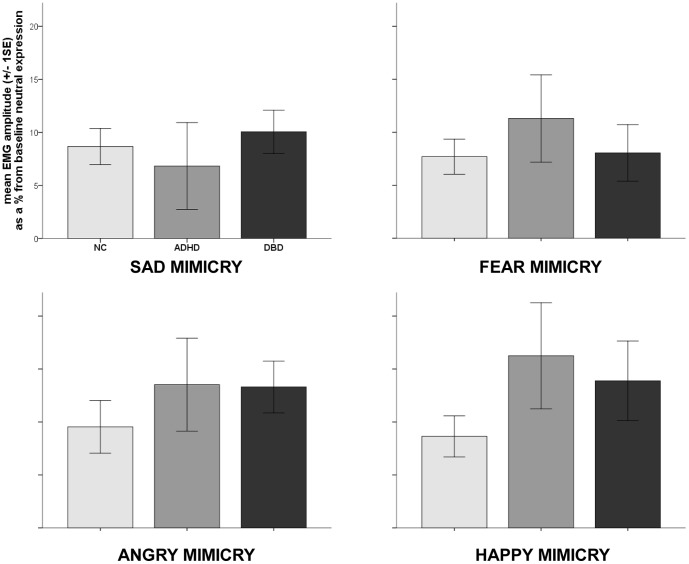
Facial mimicry response to emotional facial expressions in DBD, ADHD and healthy controls.No significant differences were shown between groups in mean EMG amplitude as a percentage from baseline neutral expression for SAD, FEAR, ANGRY and HAPPY MIMICRY presented for healthy controls, children with attention-deficit/hyperactivity disorder (ADHD) and children with disruptive behavior disorder (DBD). Error bars represent +/− 1 standard error.